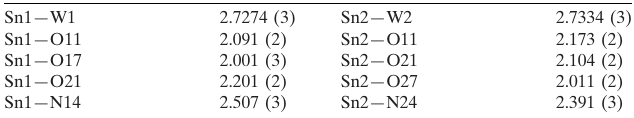
Selected bond lengths (A˚ ).